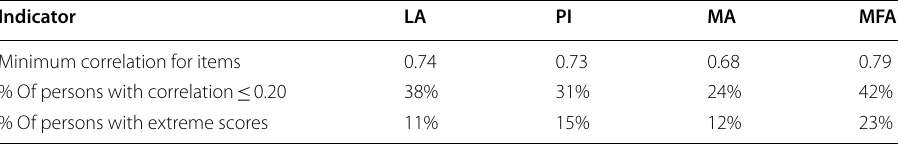
Table 2 Initial model: correlations for items and persons, and extreme scores Indicator LA PI MA MFA Minimum correlation for items 0.74 0.73 0.68 0.79 % Of persons with correlation 0.20 38% ≤